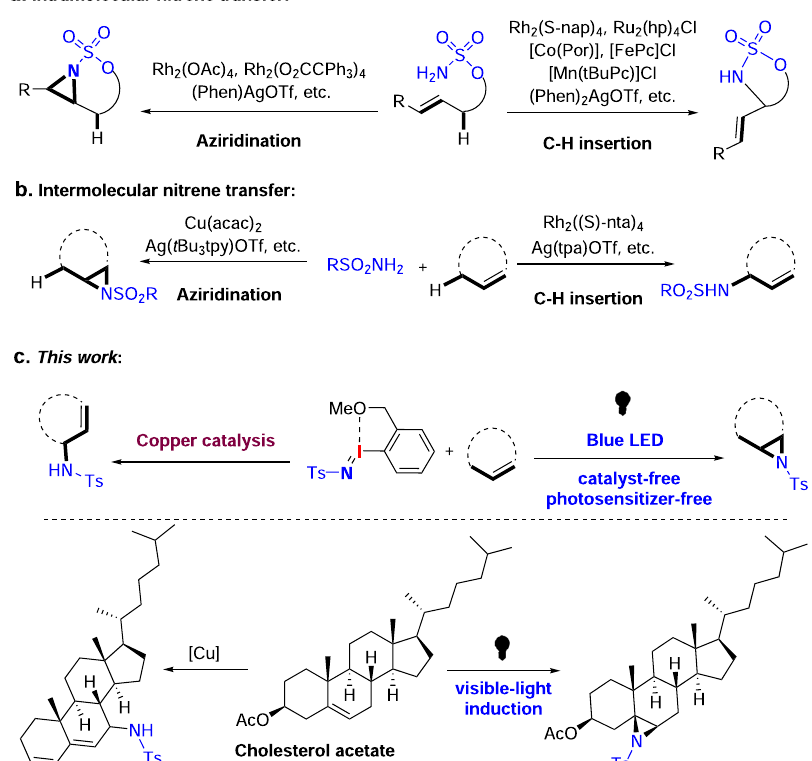
Fig. 1 Chemo- and site-selective nitrene transfer. a Intramolecular nitrene transfer reaction of unsaturated hydrocarbon compounds. b Intermolecular nitrene transfer reaction of unsaturated hydrocarbon compounds. c Combining copper and photo catalysis for nitrene transfer reaction of unsaturated hydrocarbon